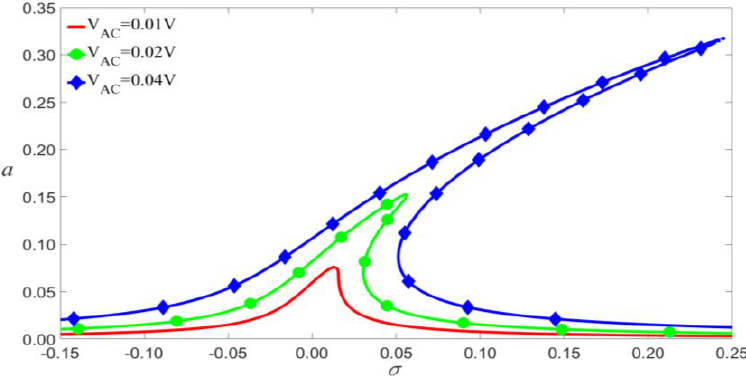
Figure 14. Frequency-response curves of primary resonance for V AC = 0.02 V.